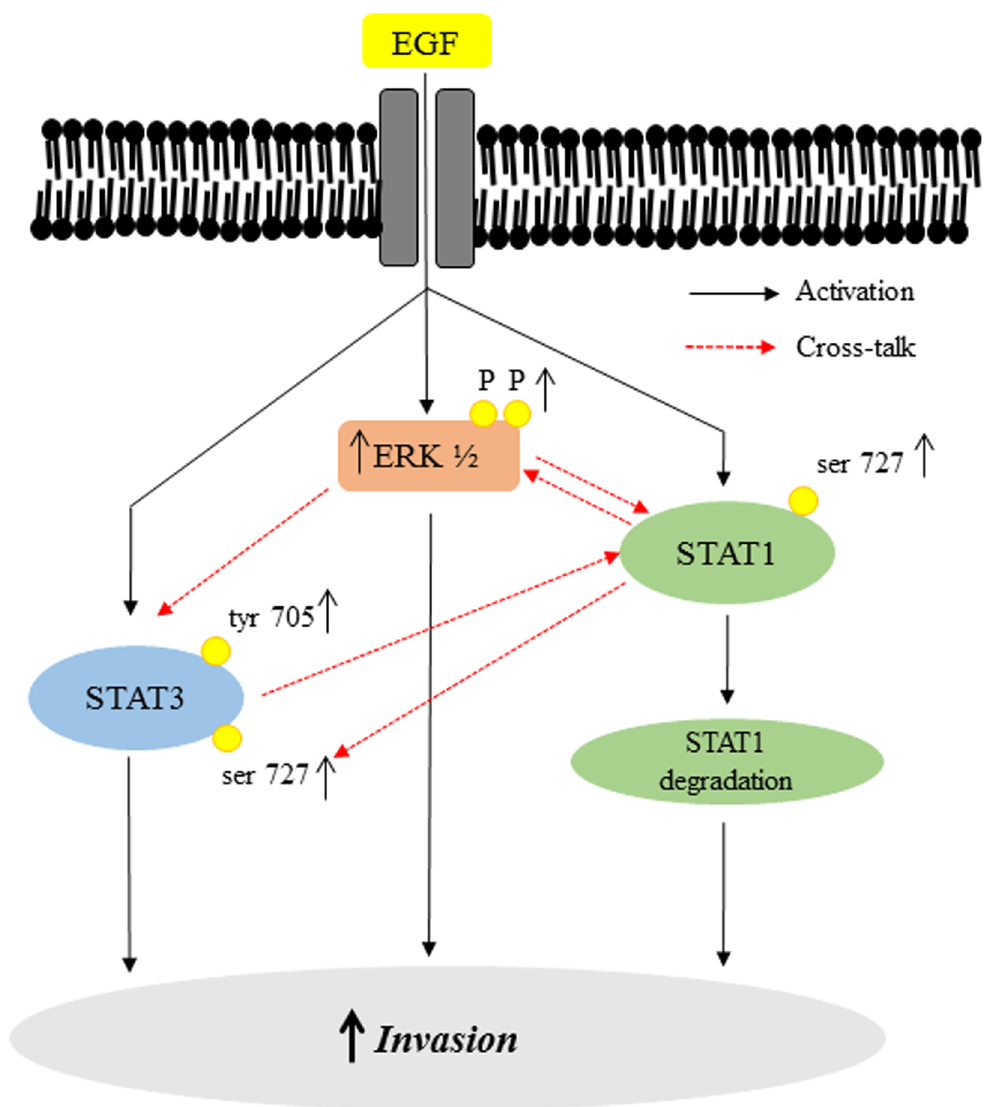
Fig 9. Schematic representation of the EGF-mediated activation of the downstream signaling pathways and their cross-talk. Bindingof EGF to the HTR-8/SVneo cells inducesincreasein phosphorylation of ERK ½ , STAT1 ser 727 and STAT3 at both tyr 705 and ser 727 residues.It also led to decrease in total STAT1. These changesmay be activatingtranscriptionof various invasionpromotinggenesleadingto increasein invasionof HTR-8/SVneo cells subsequent to EGF treatment. By using a MAPK inhibitor,inhibitionof EGF-induced ERK ½ phosphorylation led to down-regulation of activationof STAT3 (at tyr 705 and ser 727) and STAT1 (ser 727) as well as STAT1 degradationin HTR-8/SVneo trophoblastcells. However, inhibitionof STAT3 by siRNA only affects STAT1 ser 727 phosphorylation. On the other hand, STAT1 silencingby siRNA led to significantreductionin phosphorylation of ERK ½ and STAT3 ser 727 without affecting STAT3 phosphorylation at tyr 705.